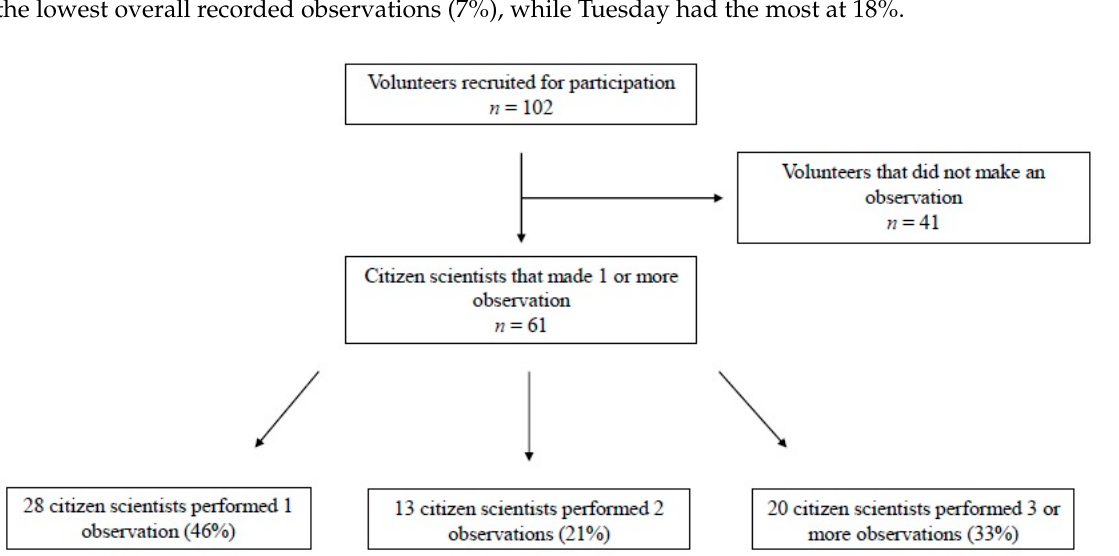
Figure 1. Volunteer recruitment and number of observations completed. Table 1. Total observations by greenway site.